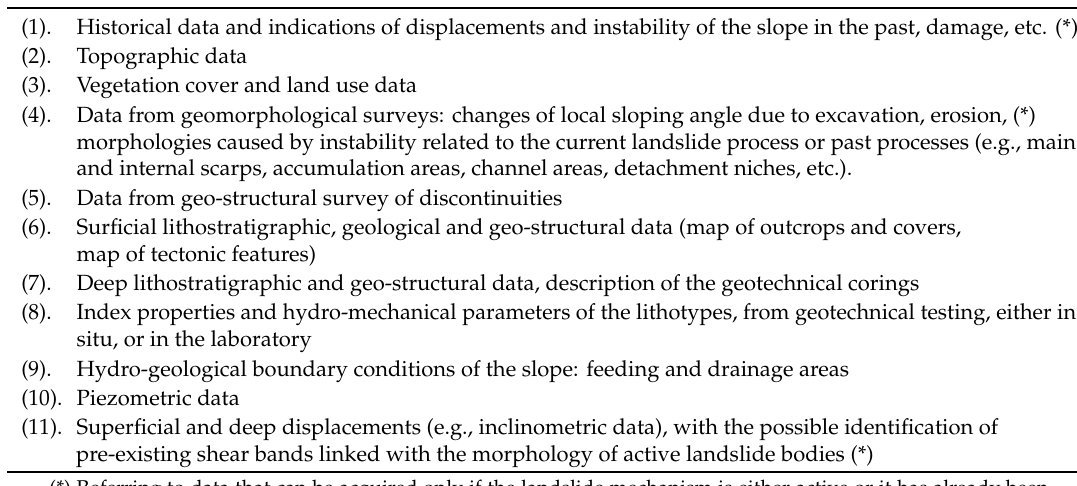
Table 2. Macrocategories of data to be acquired in the context of analyses and